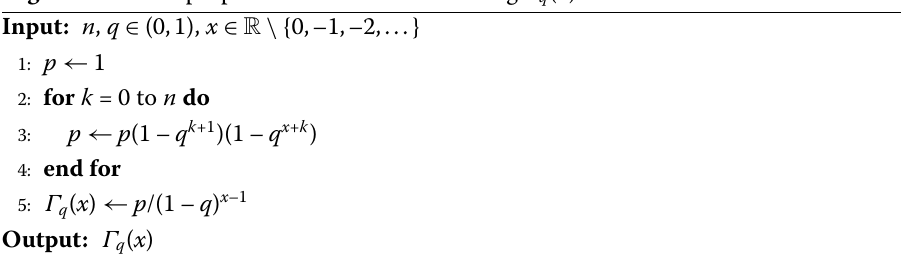
Algorithm 2 The proposed method for calculating Γ q ( x